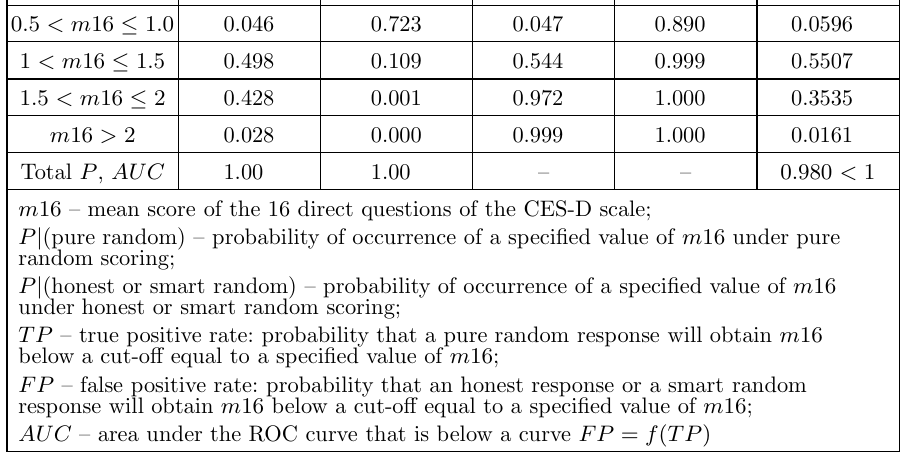
Table 4. Task of screening pure random response to the CES-D scale P | (pure P | (honest or m 16 TP FP AUC random) smart random) m 16 ≤ 0 . 5 0.000 0.167 0.0002 0.1671 0.00007 0 . 5 < m 16 ≤ 1 . 0 0.046 0.723 0.047 0.890